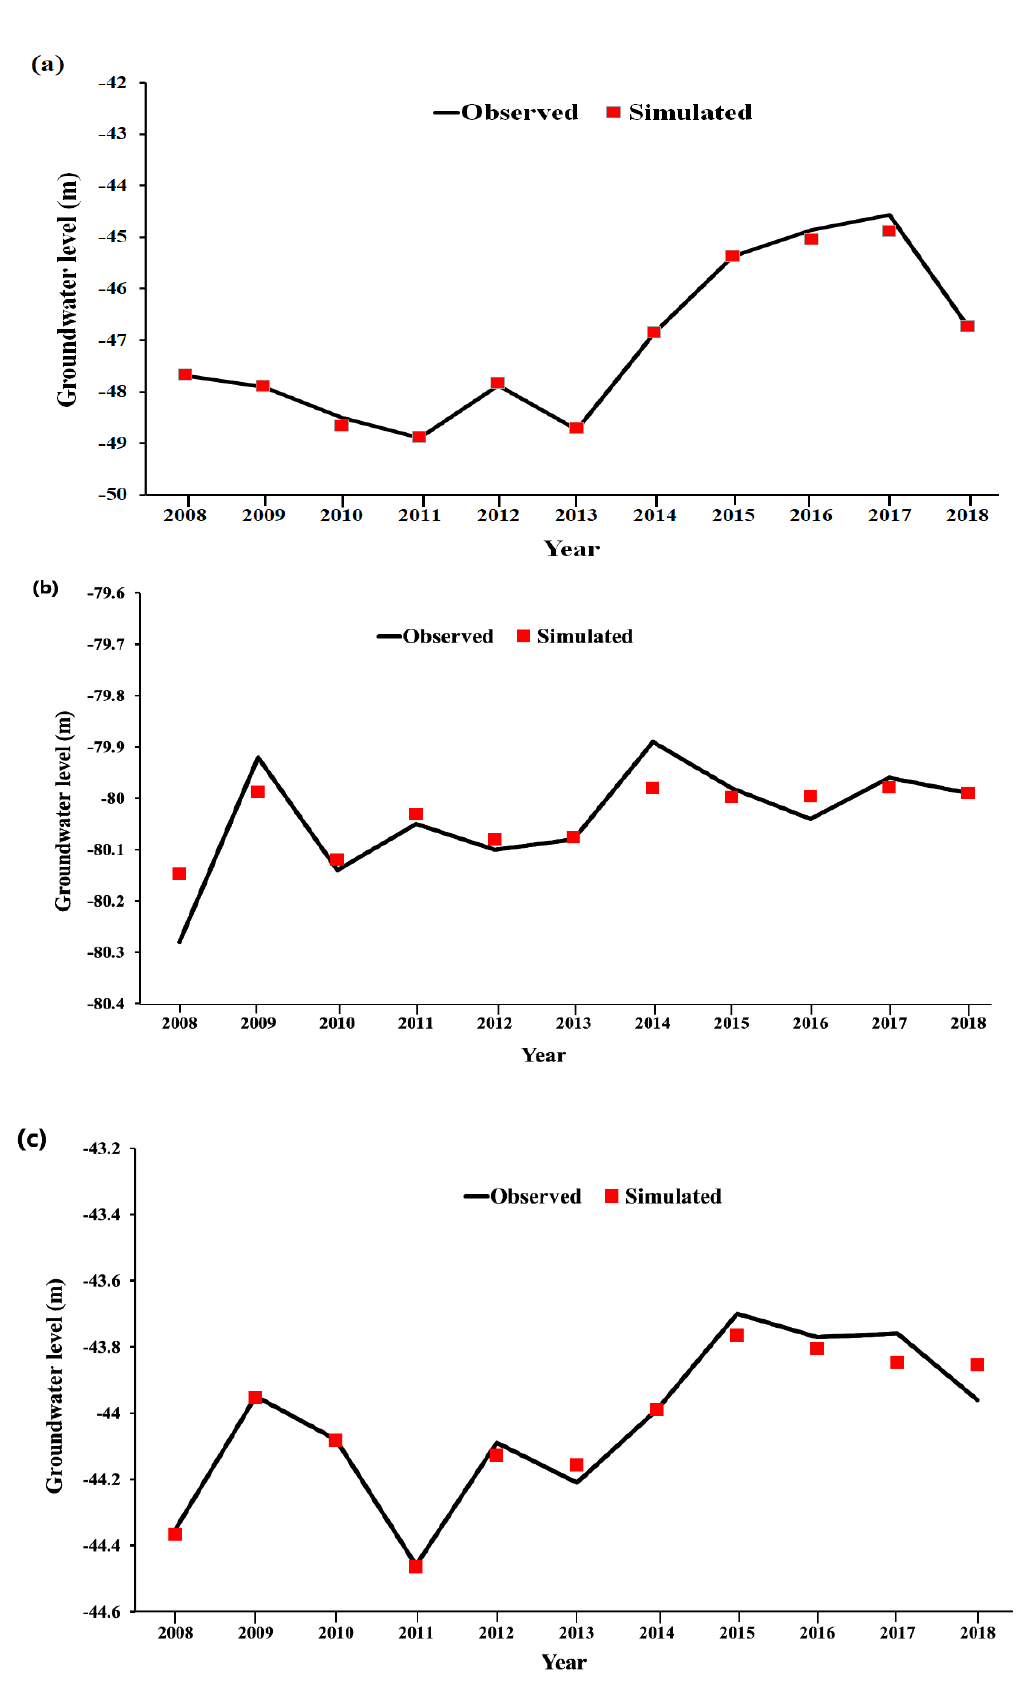
Figure 8. Observed and simulated groundwater values for the ( a ) Osan ( b ) Hwasong ( c ) Pyeongtaek subareas by using the ANN.